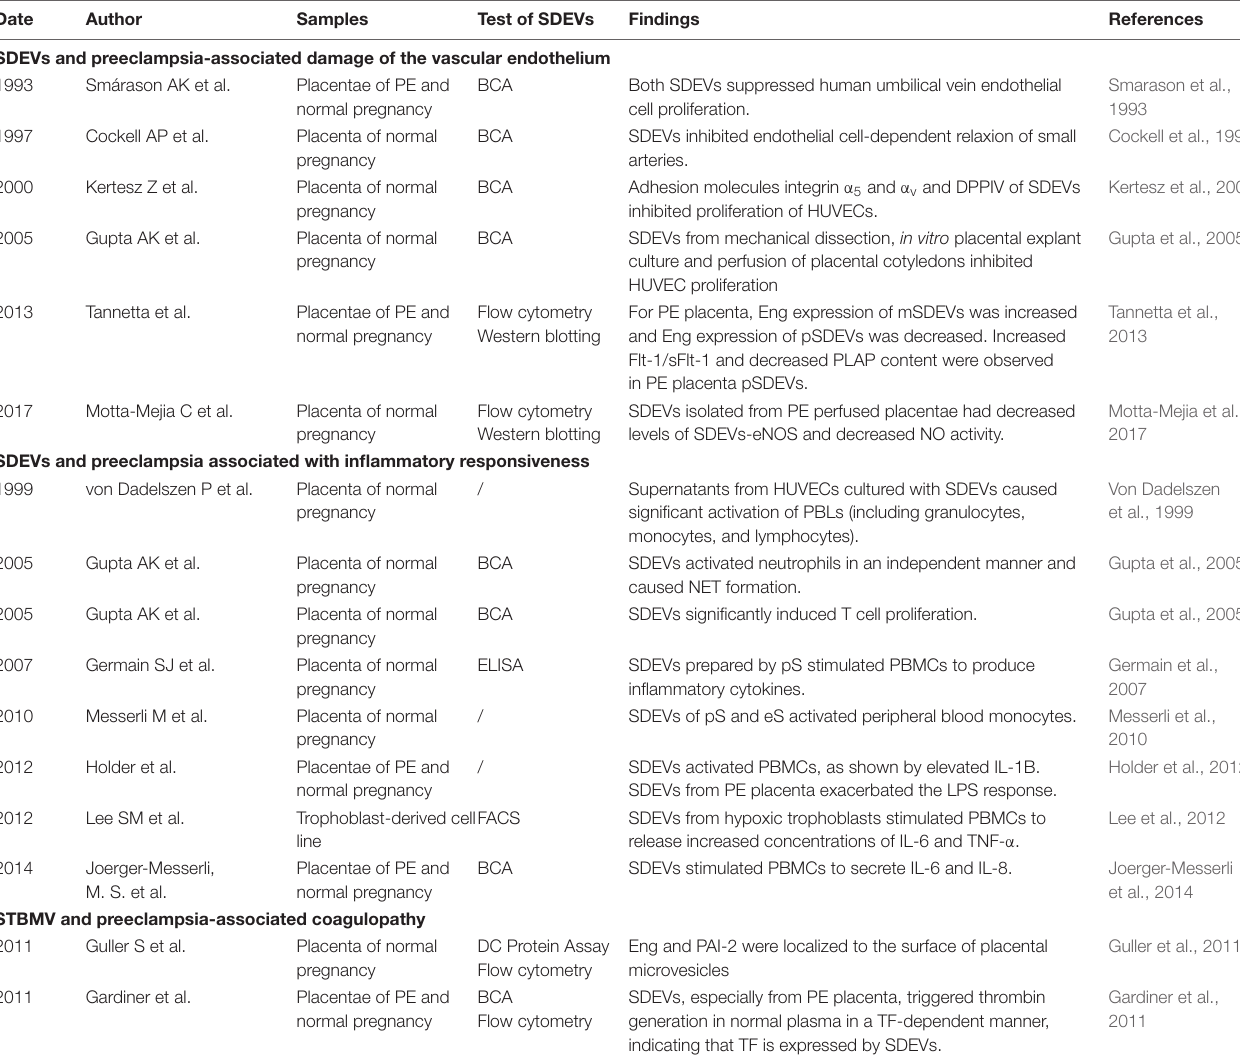
TABLE 1 | Analyses of SDEVs in experiments in vitro and the pathogenesis of